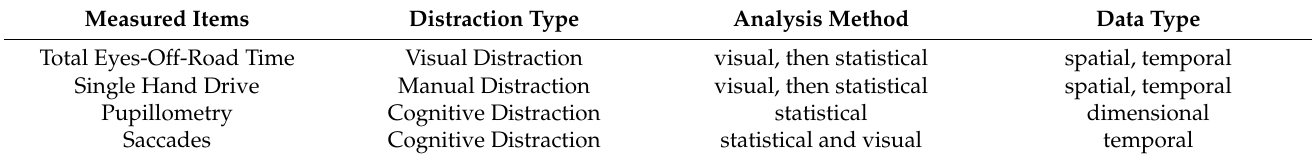
Table 1. Driving test measured items, distraction types, analysis methods and data types.